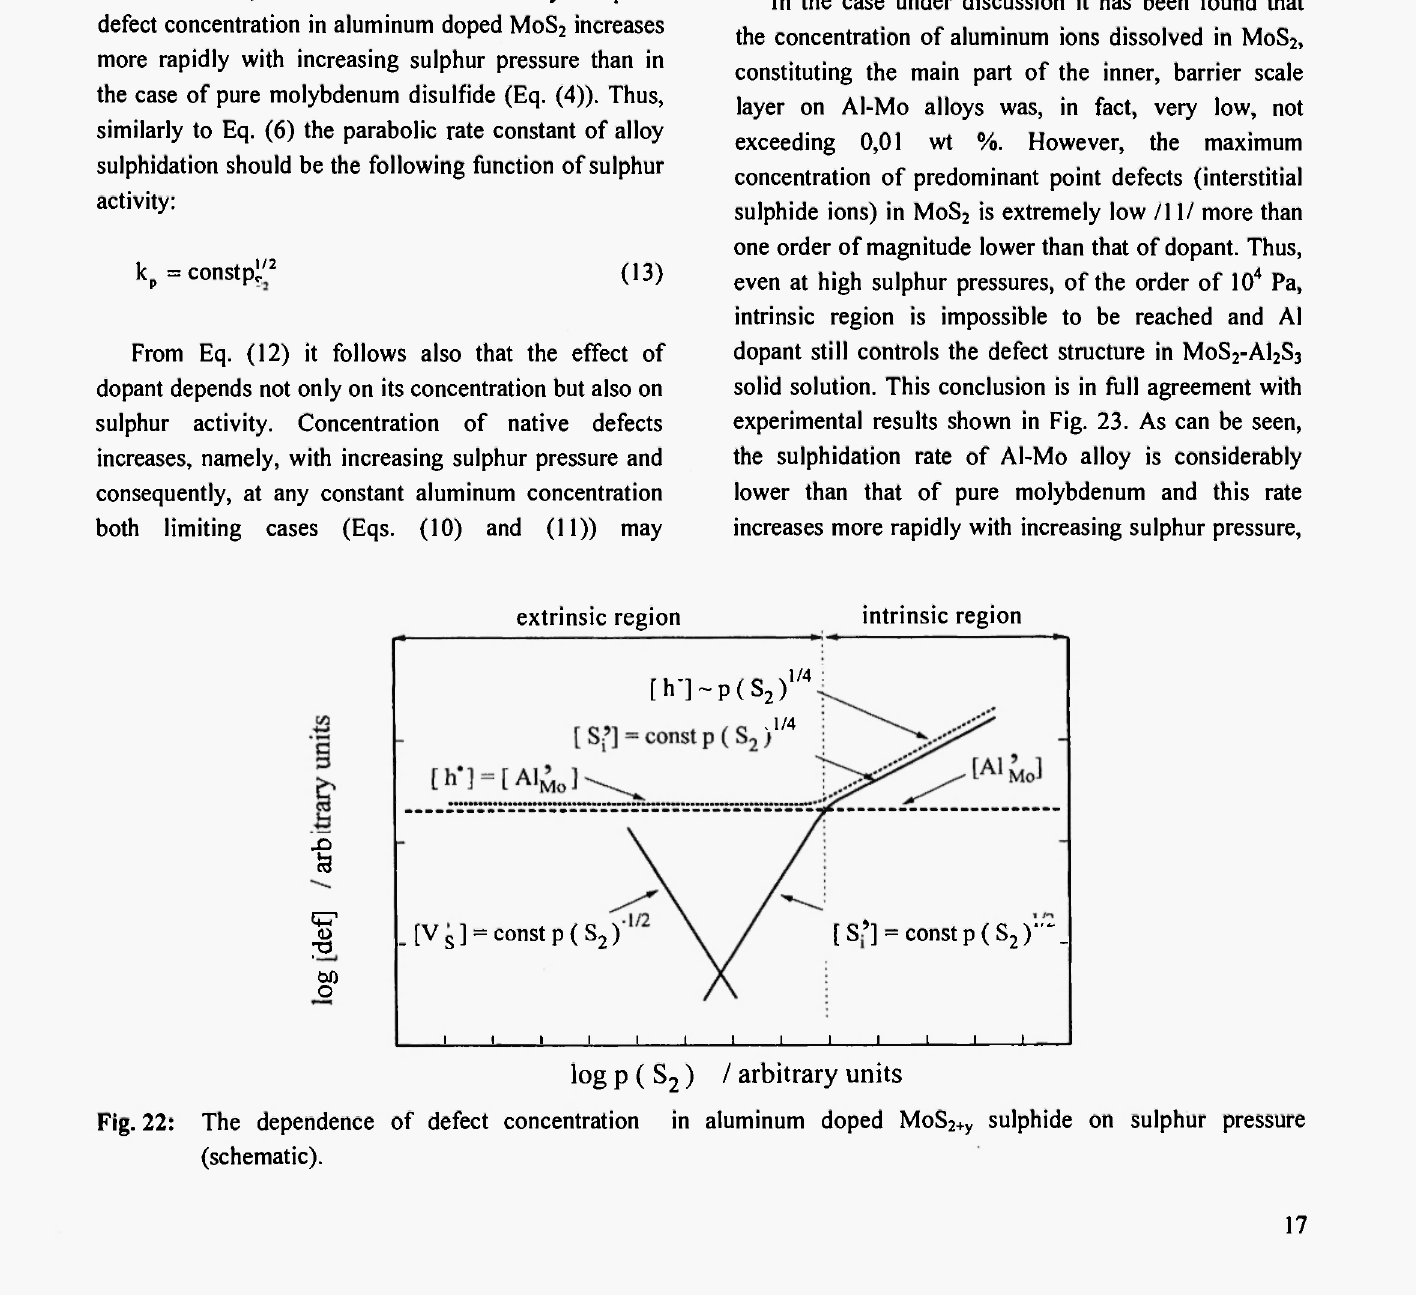
/ arbitrary units